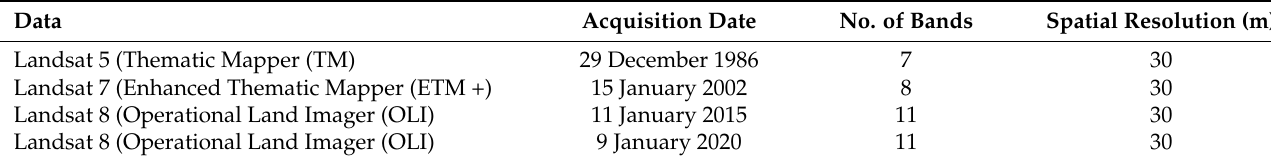
Table 1. Information on Landsat images acquired for the study.